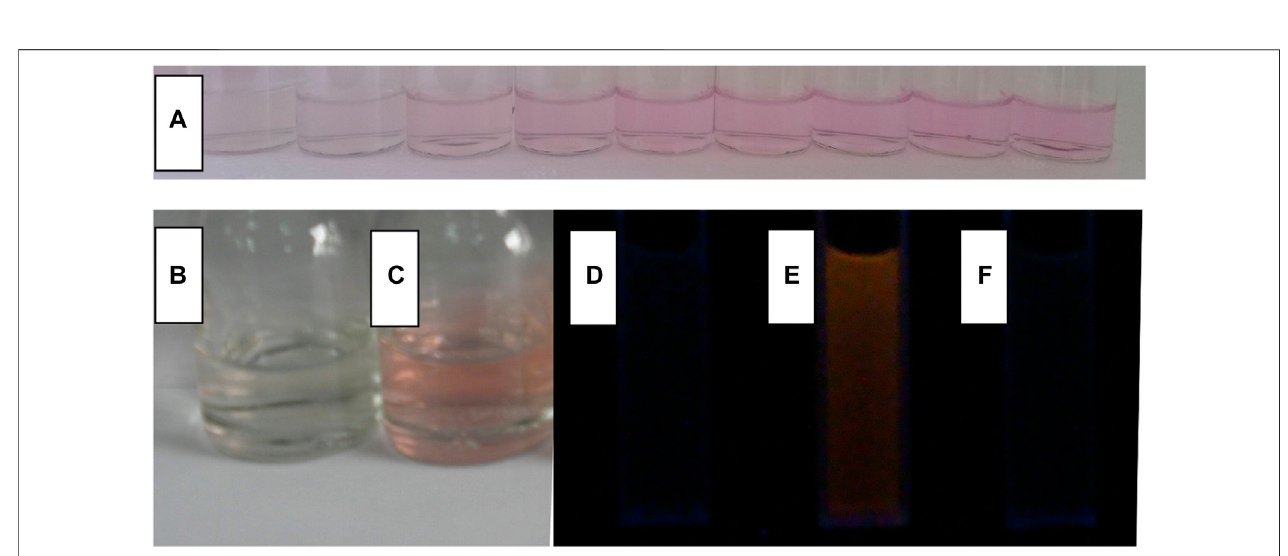
FIGURE 4 | Emission spectra ofchemosensors (10 μ M) upon various interfering metal ions (5.0 equiv) in the aqueous (containing 5% ethanol asa co-solvent), (A) , CS1; (B) , CS2; (C) , CS3.